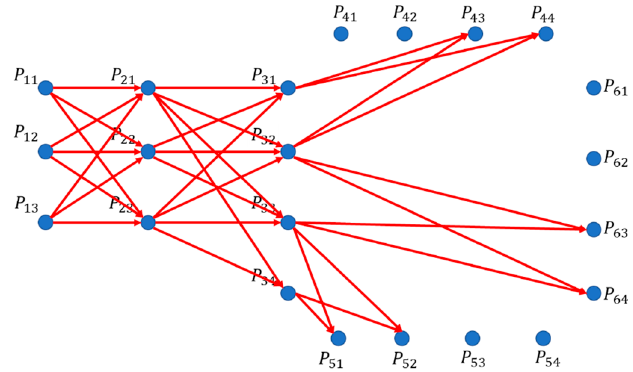
Figure 18. The abstracted directed graph. Blue dots represent nodes, and red lines represent edges.